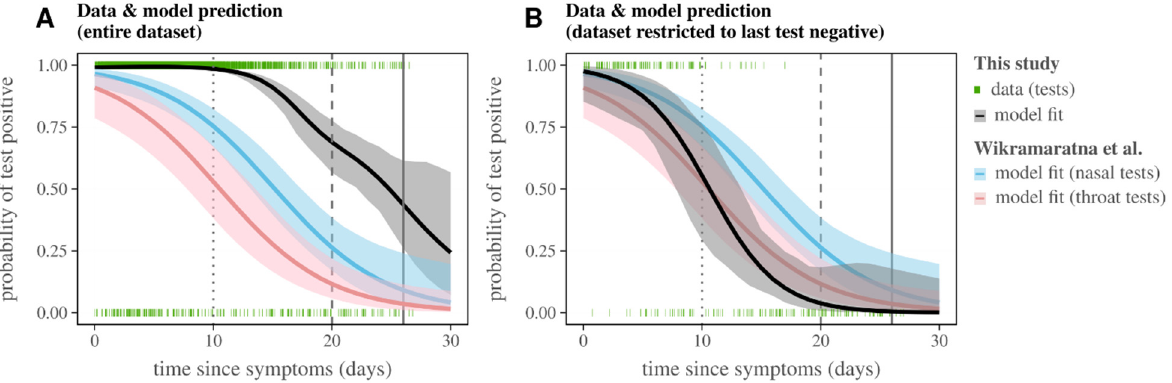
Figure 6. SARS-CoV-2 probability of positive test dependent on time from symptom onset. ( A ) Model fit (black line and grey area) for positive and negative tests (red bars at 1 and 0, respectively) in this study’s dataset (iii) (see RT-PCR sub-datasets for details), selecting only individuals who had at least one positive test and with a single reported date of symptom onset. ( B ) Model fit (black line and grey area) for positive and negative tests (red bars at 1 and 0, respectively) in this study’s dataset (iii) (see RT-PCR sub datasets for details), restricted to those for whom the last test was negative. ( A , B ) The pink and blue lines (and respective areas) are the predictions by Wikramaratna et al. [42] dependent on sample type, with nasal samples in blue and throat samples in pink.